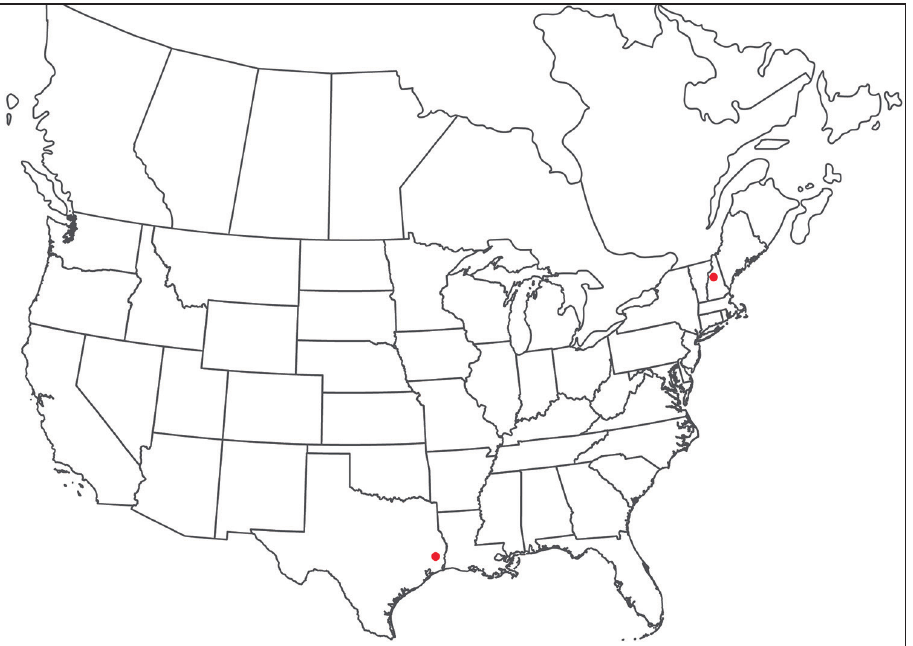
Figure 196. Torrenticola priapus sp. n.